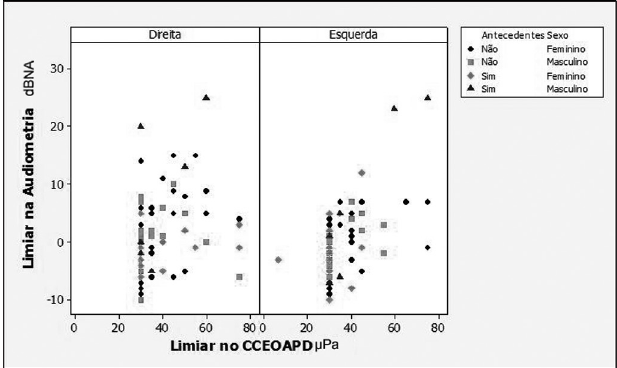
Figura 3. Diagrama de dispersão dos limiares audiométricos e dos limiares das curvas de crescimento das EOA-PD, considerando as variáveis: orelha, antecedentes de otite média e sexo- 4000 Hz.